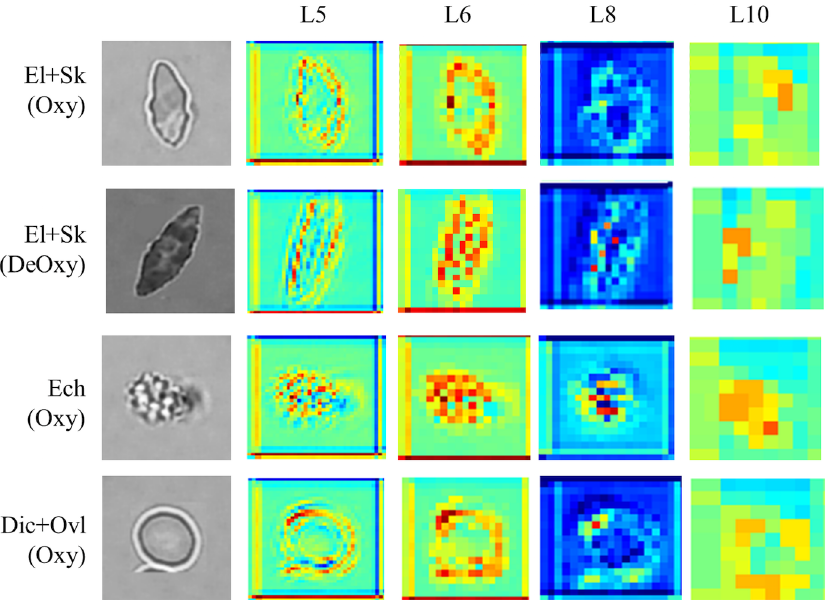
Fig 20. Learning hierarchical feature maps for layers 5, 6, 8, 10 for Dic+Ovl (Oxy), Ech (Oxy), El+Sk (Oxy), El+Sk (DeOxy).